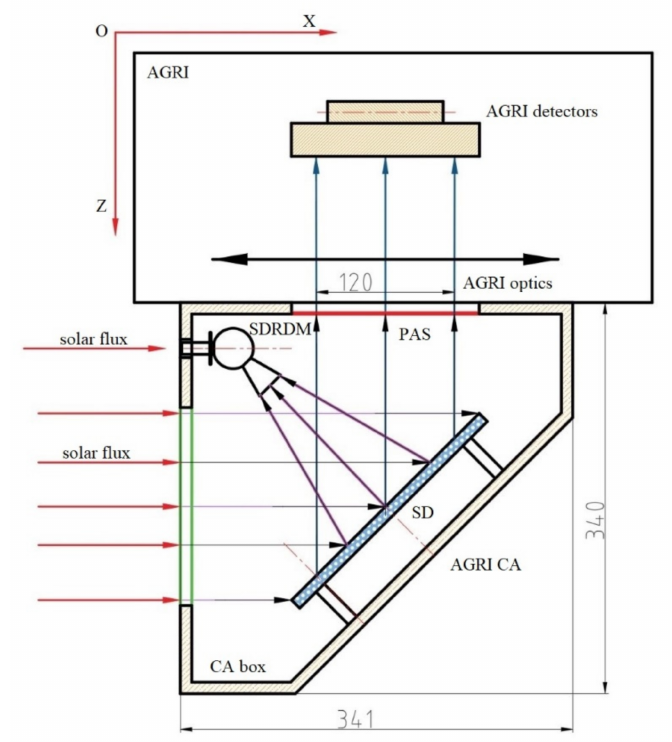
Figure 1. Composition diagram of the AGRI